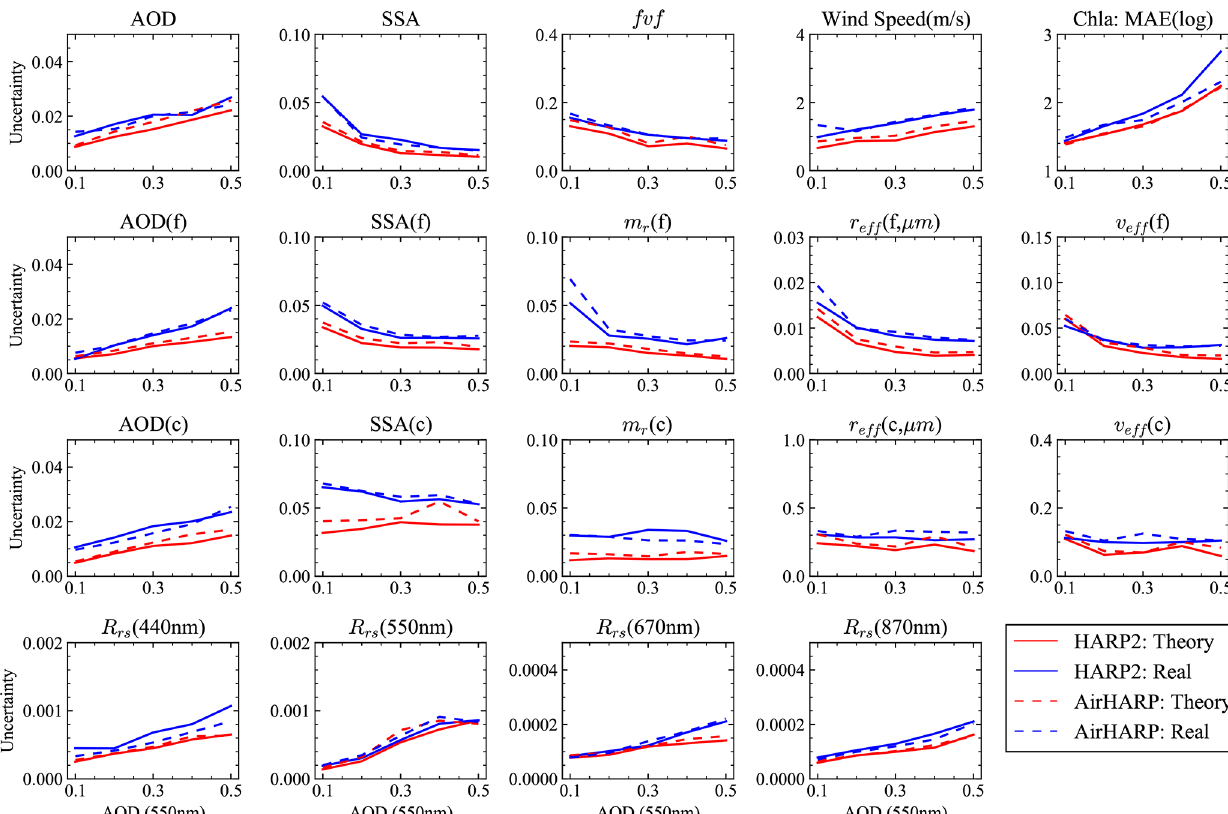
Figure 7. The retrieval uncertainties represented by MAE averaged within several ranges of AOD at 550nm, including [0.01, 0.1], [0.1, 0.2], [0.2, 0.3], [0.3, 0.4], and [0.4, 0.5]. The horizontal axes indicate the maximum AOD used in the corresponding AOD range. Results for both HARP2 and AirHARP are shown. Chl a in terms of MAE ( log ) as defined in Eq. (12) is